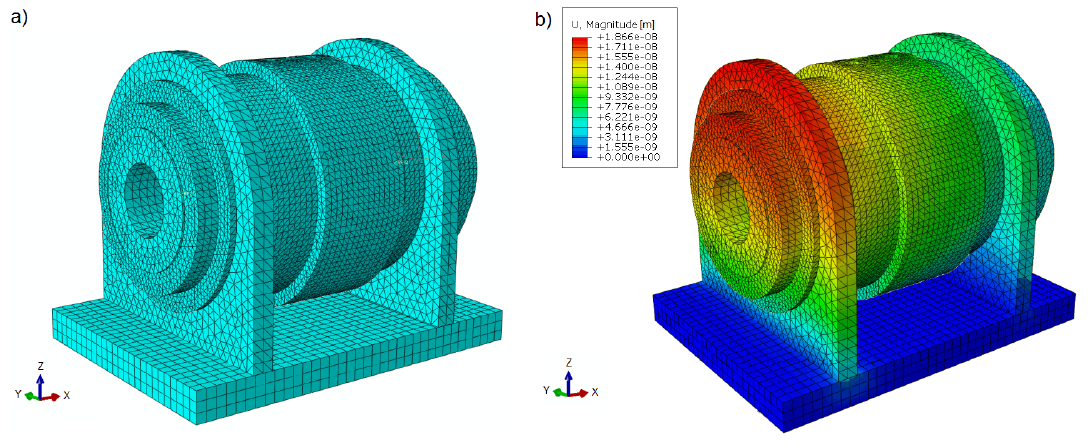
Figure 17: A simplified FEM model of the micro-turbine body, developed for analyzing the stiffness of bearing supports (a) and the distribu- tion of displacements caused by the static force acting on the bearing support No. 1 in a horizontal direction (b).